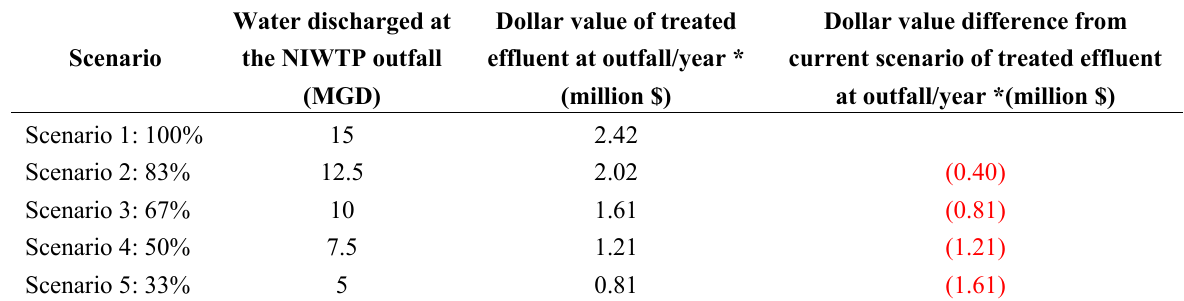
Table 2. Estimated price of domestic-use water, based on calendar year 2013 ( *